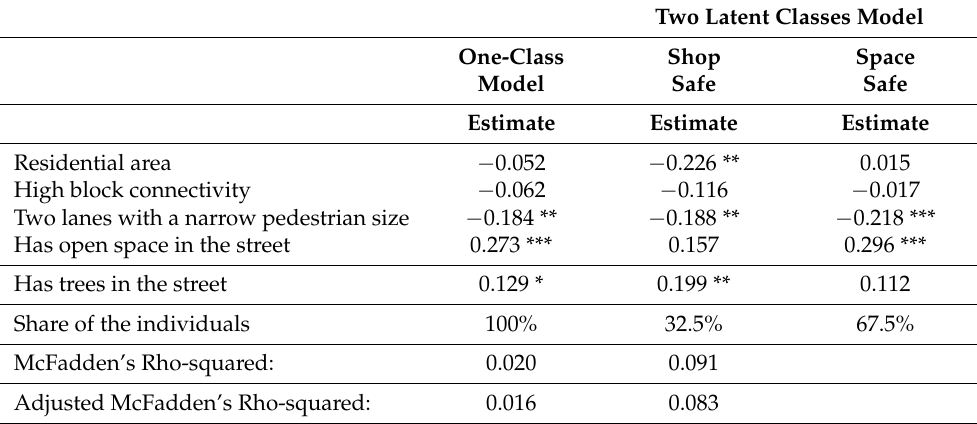
Table 13. Results for latent-class regression models ( secure sense